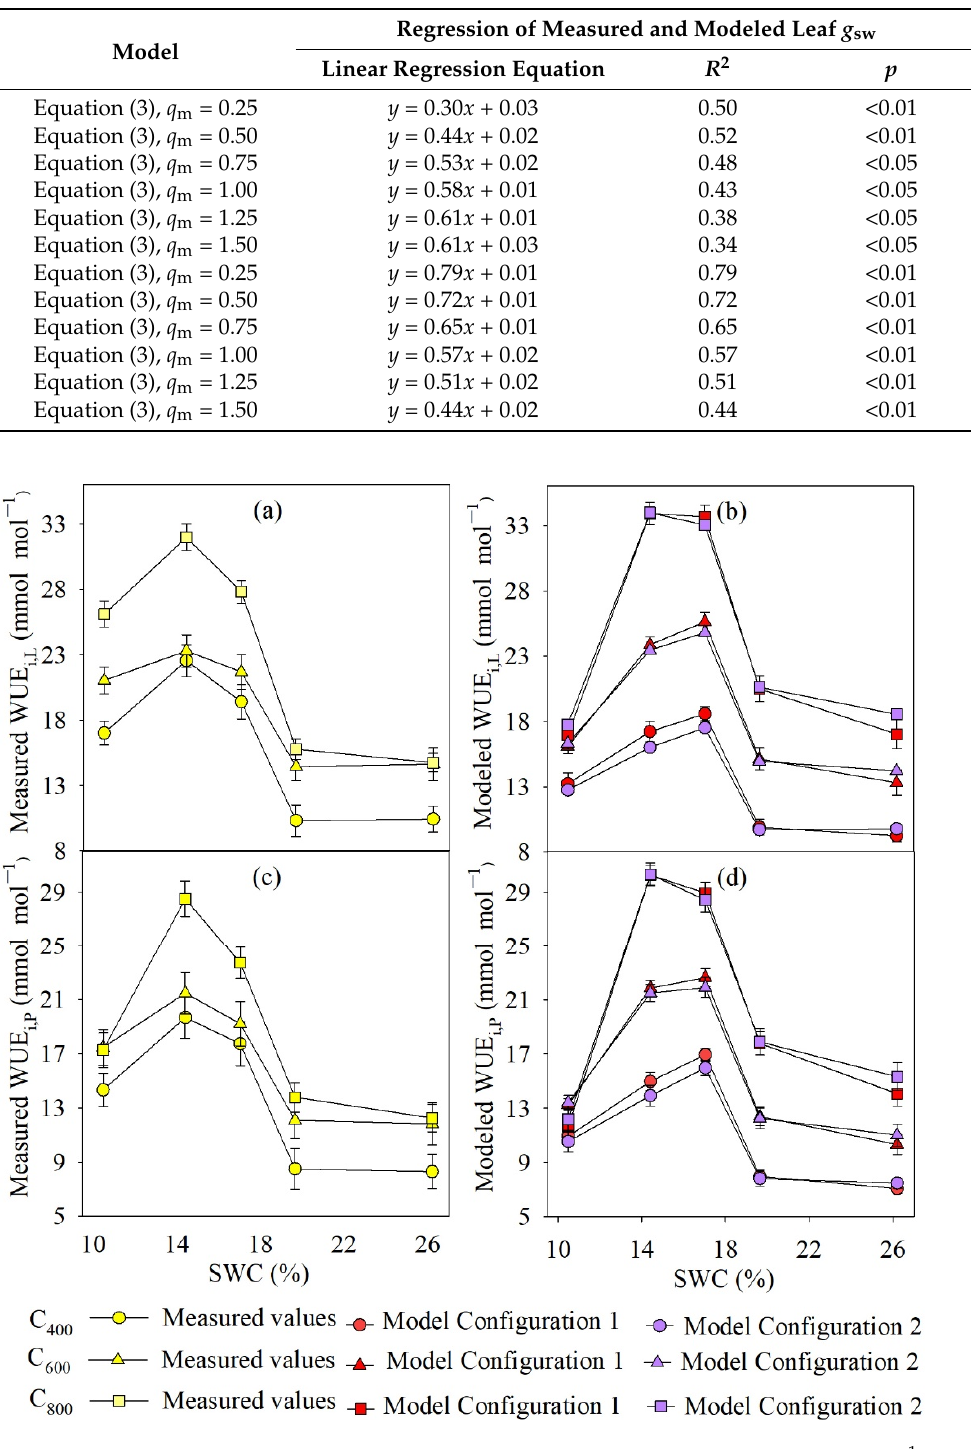
Table 2. Correlation analysis between measured and modeled leaf mesophyll conductance ( g m,